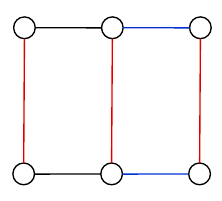
Figure 6. A graph G is 3-edge colorable.